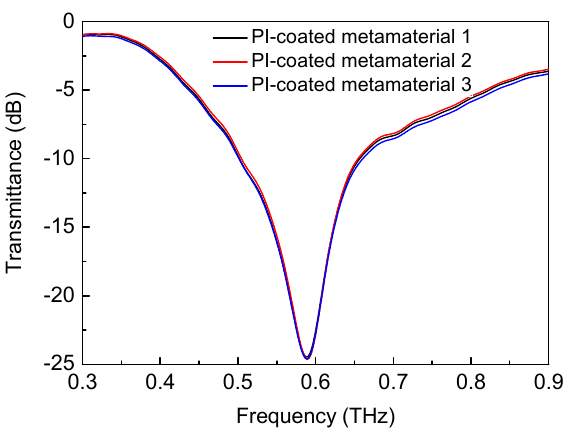
Figure 2. Experimental spectra of three metamaterials that are coated with polyimide (PI) layers.